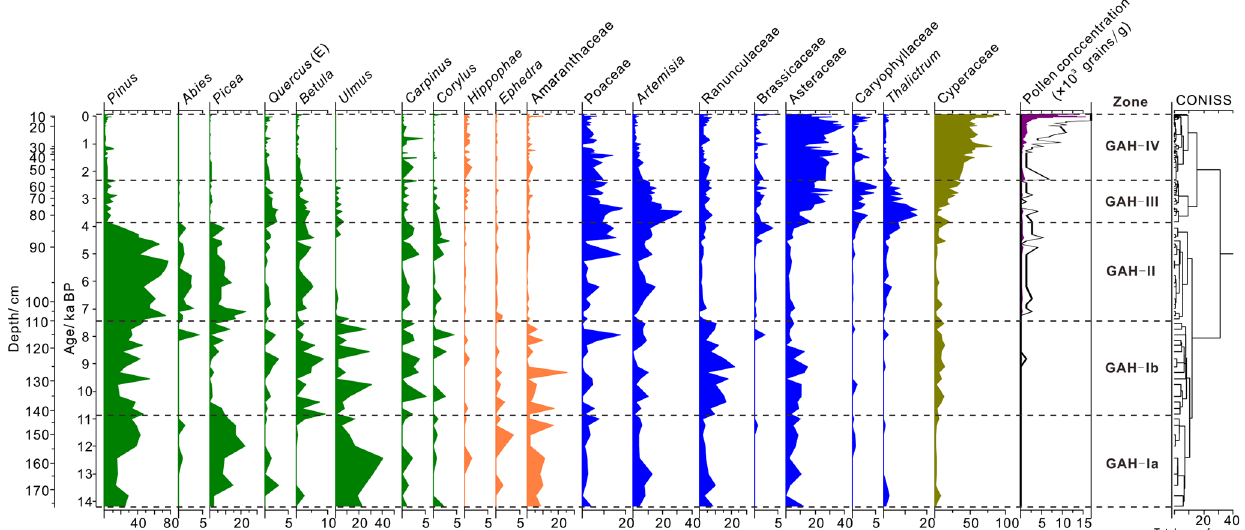
Figure 5. Pollen diagram of the main fossil pollen taxa in Gahai Lake, northeast Tibetan Plateau.